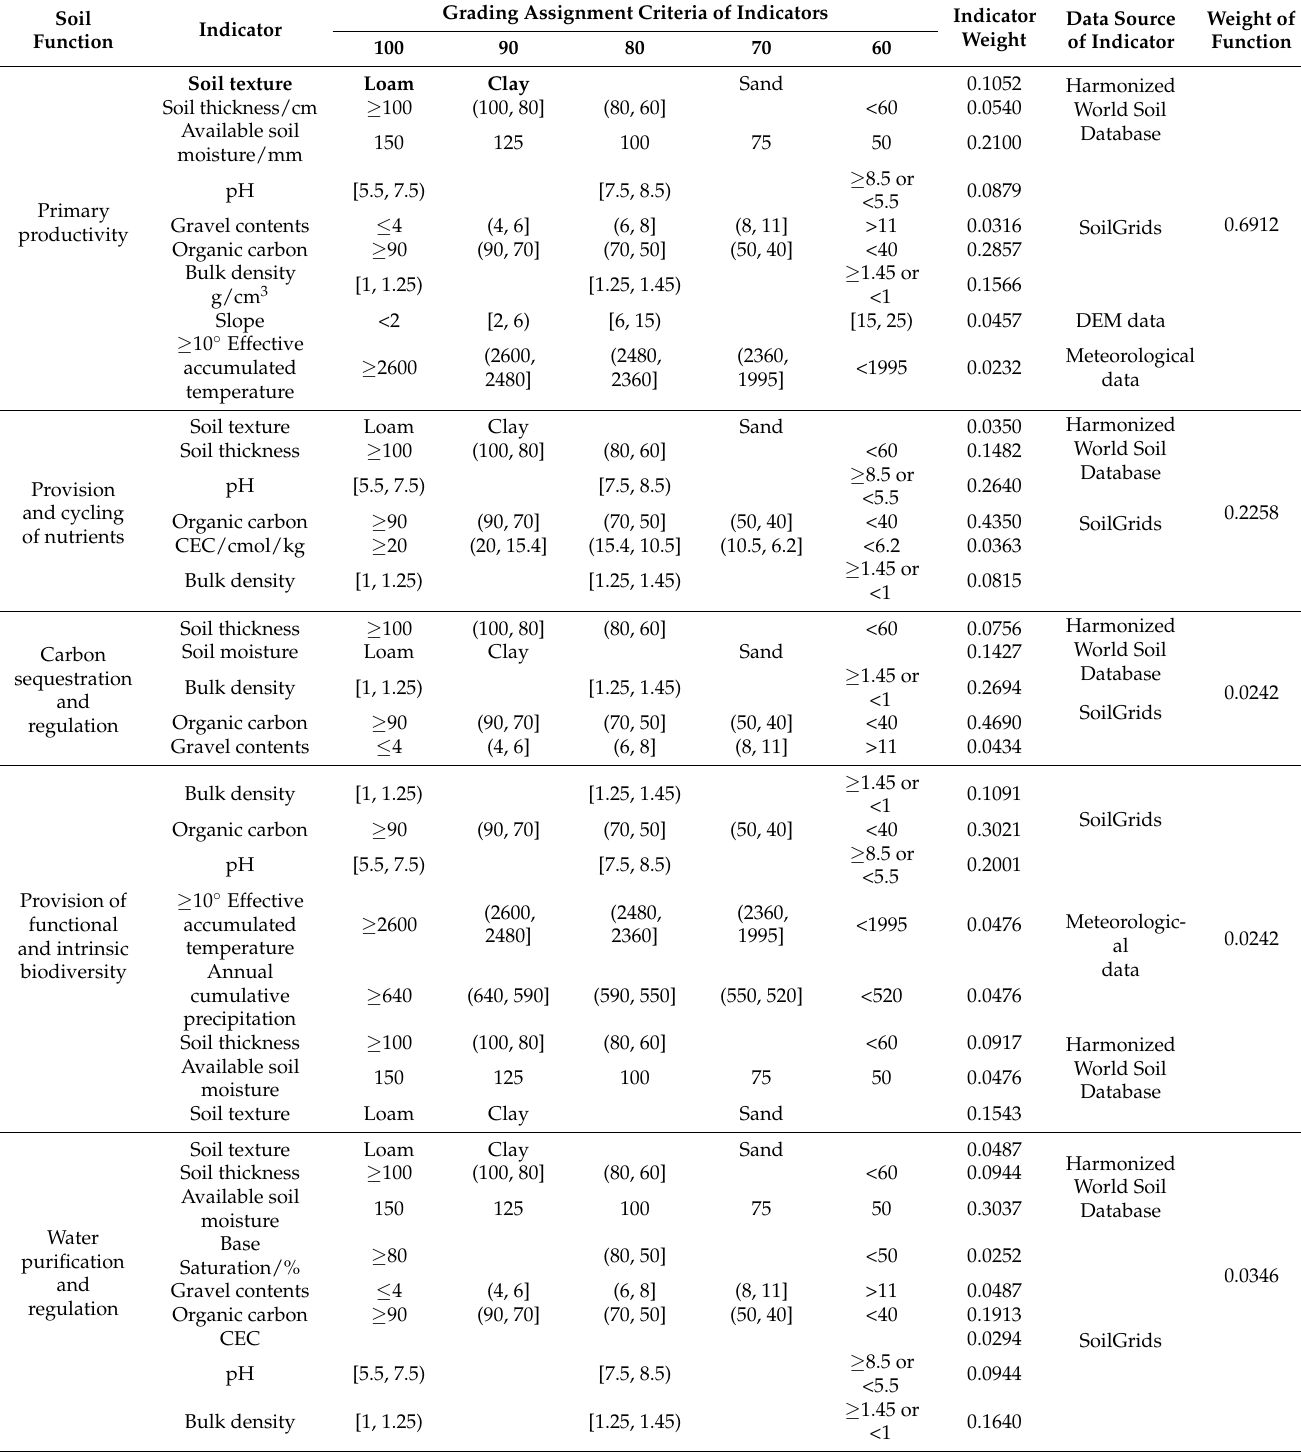
Table 2. Grading assignment criteria and weights of cultivated land soil function evaluation